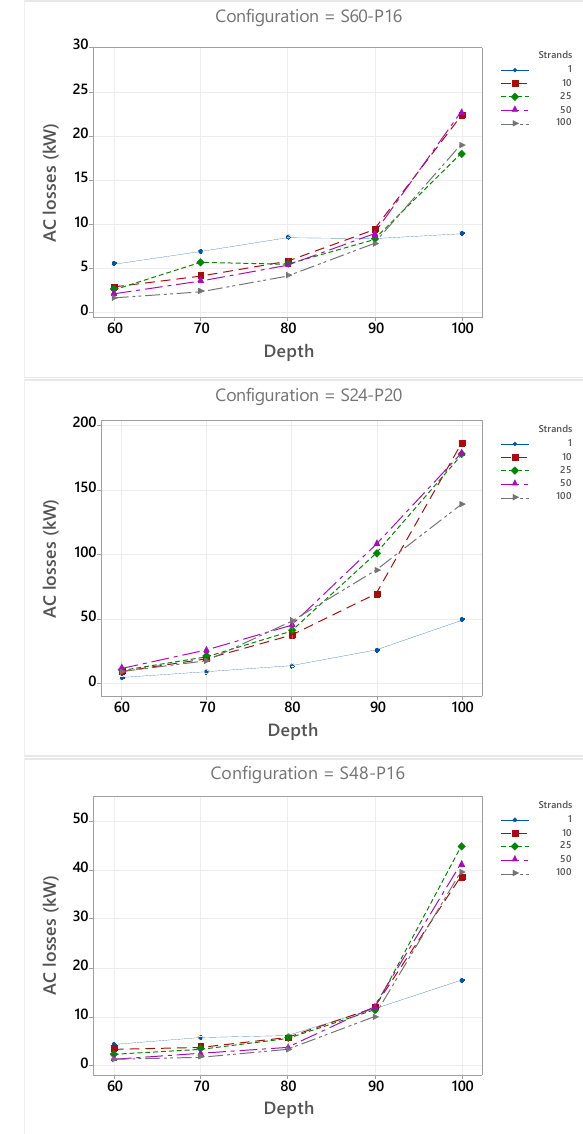
Figure 7. Stranding effect on the AC/DC loss ratio.